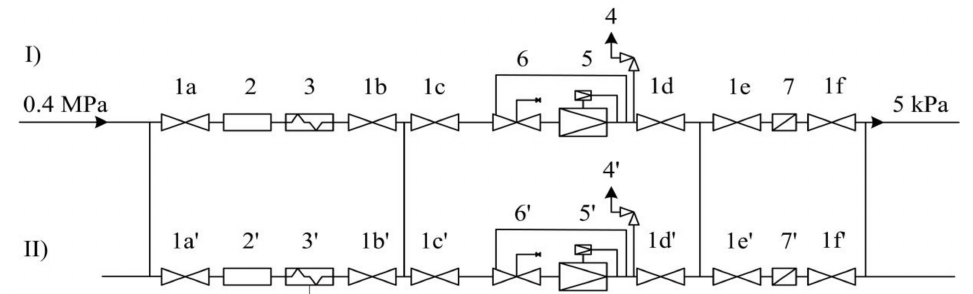
Figure 3. Diagram of a reduction and measuring station, on the basis of Tch ó rzewska-Cie´slak [36],